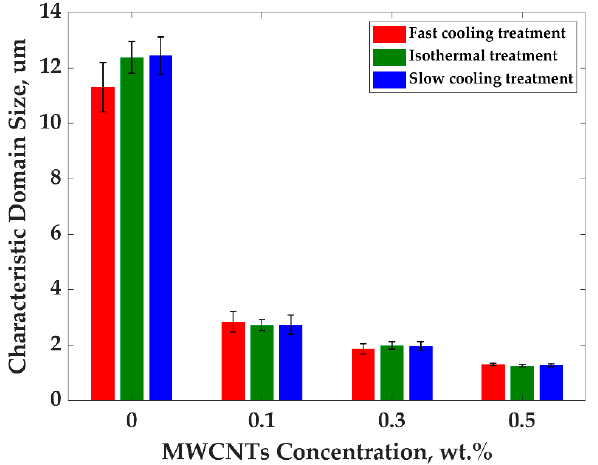
Figure 6. Characteristic domain size of ζ vs. MWCNTs concentration for different treatments for PP/PS/MWCNTs composites.